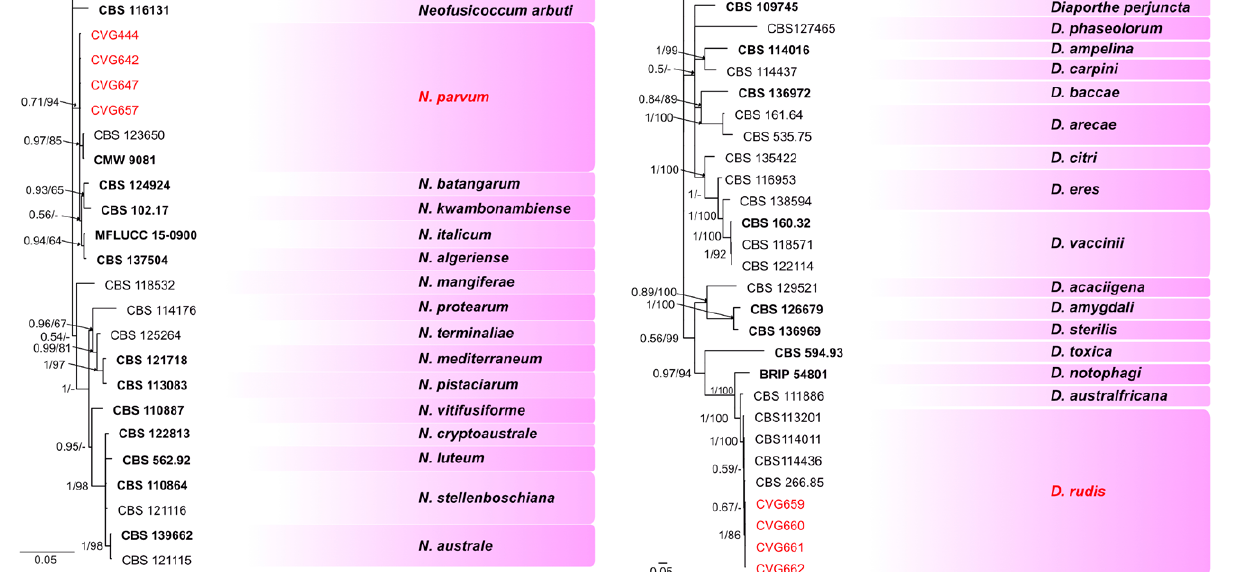
Figure 4. Consensus phylogram of 2,302 trees resulting from a Bayesian analysis of the combined ITS, tef1 and tub2 sequences of Diaporthe strains. Bayesian posterior probability values and boot- strap support values are indicated at the nodes. The tree was rooted to Diaporthella corylina (CBS 121124).